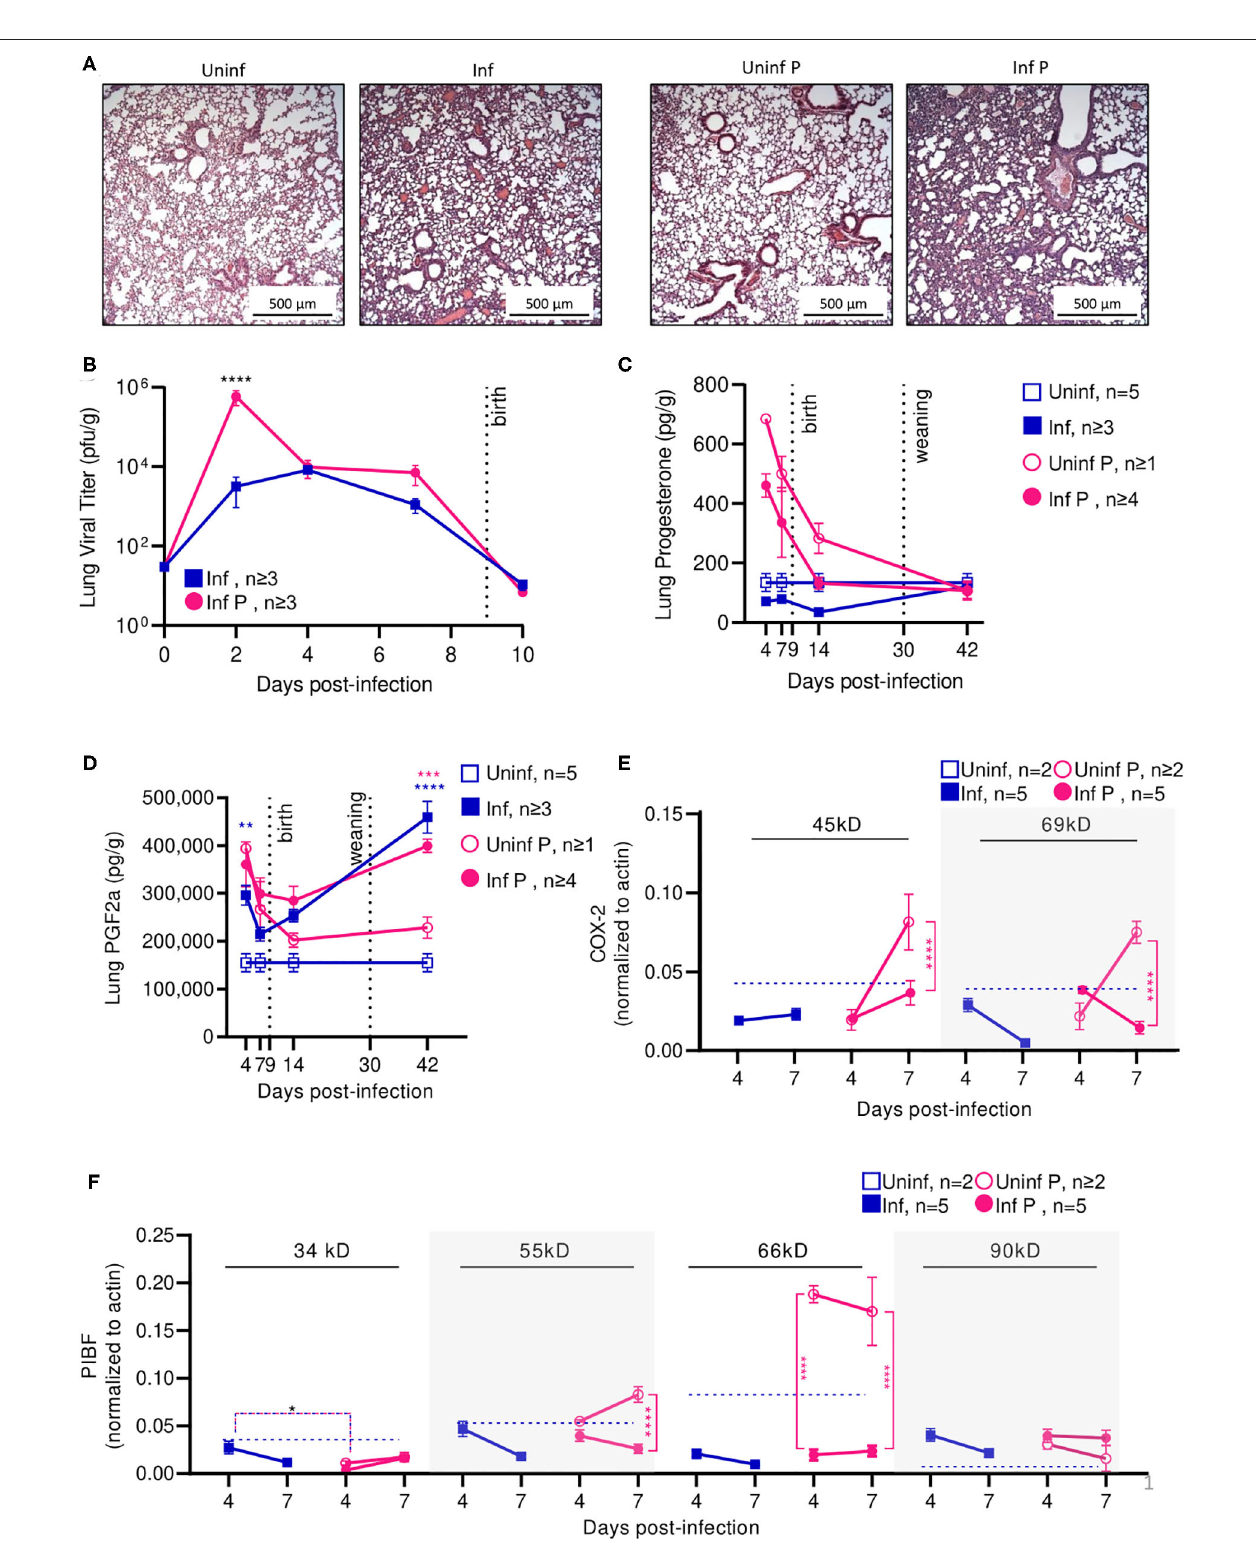
FIGURE 3 | Pregnant mice demonstrate elevated viral titers in lungs and show dysregulated hormone-mediated inflammatory responses during influenza infection. (A) Representative H&E histology of lungs from pregnant and non-pregnant mice infected with 0.5xLD50 at 4 DPI. (B) Viral titer was determined for pregnant and non-pregnant infected animals by plaque-forming assay at 0, 2, 4, 7, and 10 DPI. Concentrations of (C) progesterone and (D) PGF2 α from lung protein lysates were